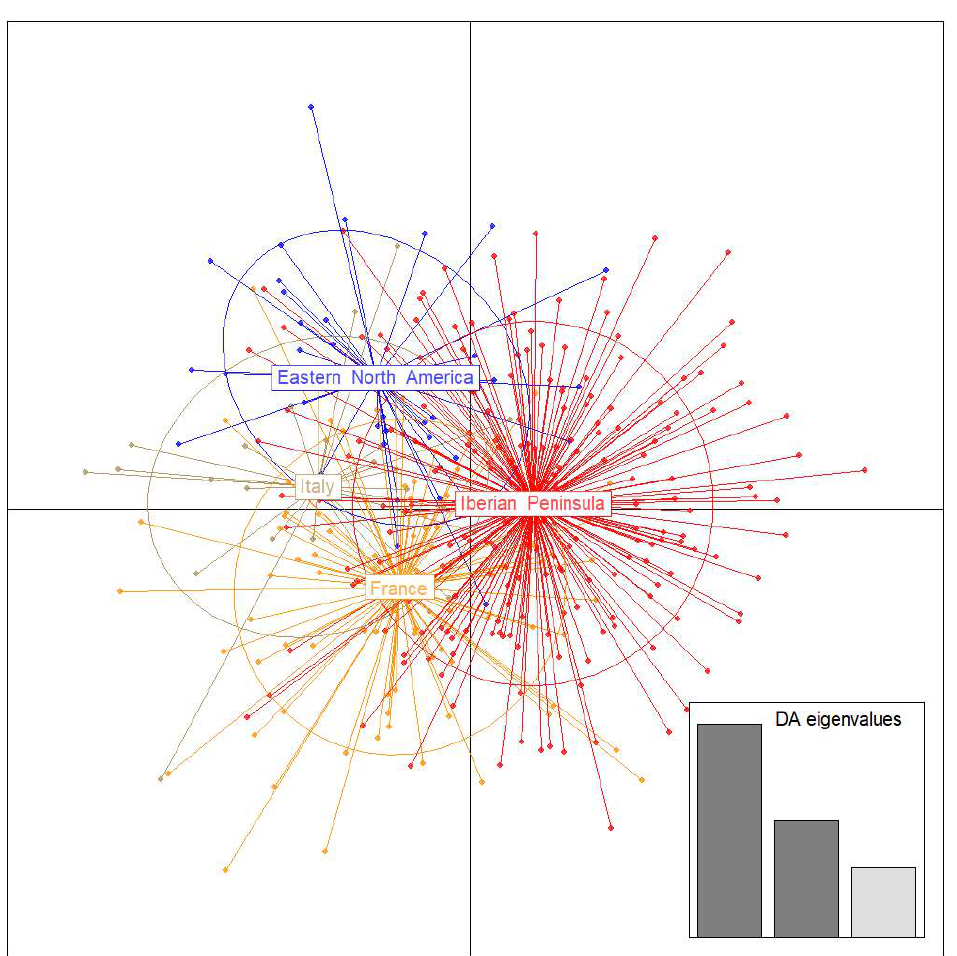
All individuals were analysed using STRUCTURE software to decipher the popula- tions’ structure further. The results were consistent with the previous analyses. Evanno’s method highlighted three main potential genetic clusters, with a smaller distinctive peak at K = 8 (Supplementary Material Figure S4). For K = 2, all the Iberian populations but Barcelona clustered together, whereas the French populations showed signs of admixture (Figure 3; Supplementary Material Figure S5B). For K = 3, two of the clusters were more defined than the third one. The eastern North American populations clustered together with Alessandria and Barcelona, and the populations of Almeria, Valencia, Soria, and Val- ladolid grouped together. Populations belonging to the third cluster were less clear but included the French populations and western Iberia (Supplementary Material Figure Figure 2. Discriminant analysis of principal component (DAPC) for Leptoglossus occidentalis populations. S5A). At K = 8, Barcelona, Almeria, and Montreal were clustering alone.